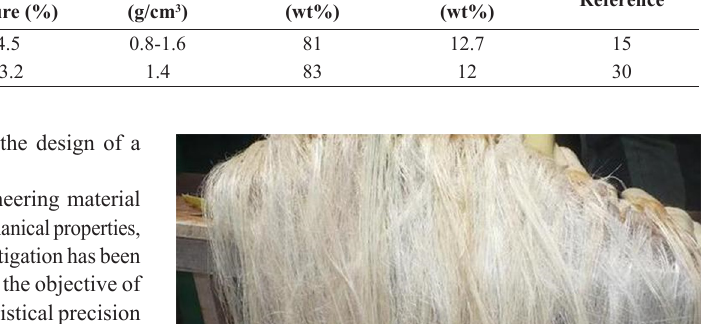
Table 1. Mechanical properties and structural compositions of pineapple leaf fibers. Tensile Strength (MPa)